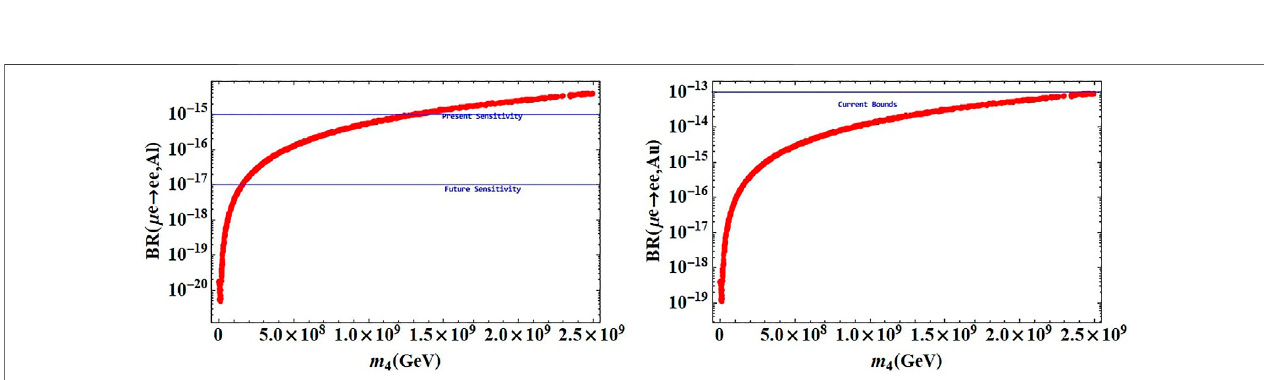
FIGURE 5 | CR ( μ − e , N ) as a function of the sterile neutrino mass with two different targets. The blue horizontal line represents the experimental bounds on this process.